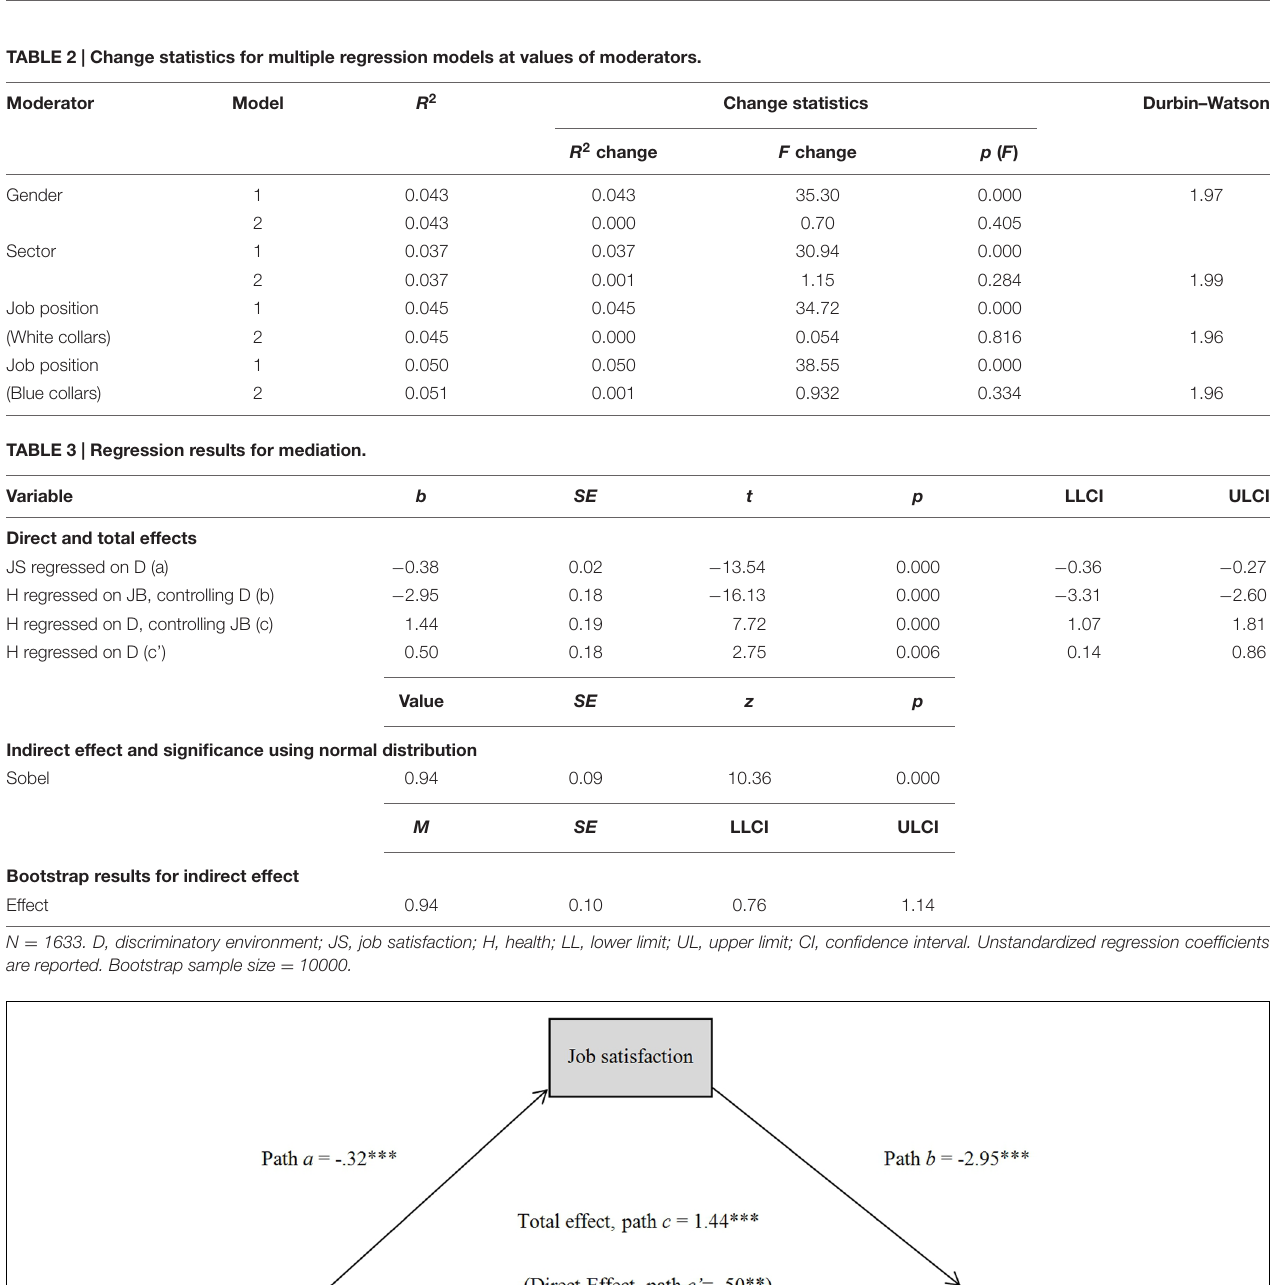
TABLE 2 | Change statistics for multiple regression models at values of moderators.